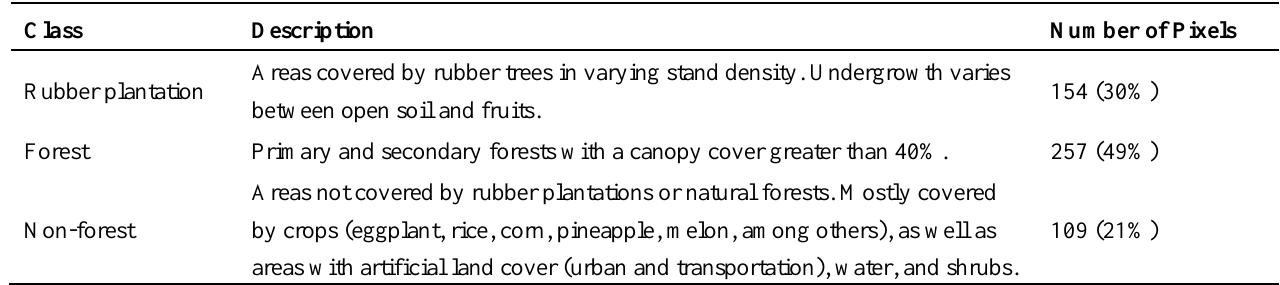
Table 1. Reference classes and number of reference pixels.